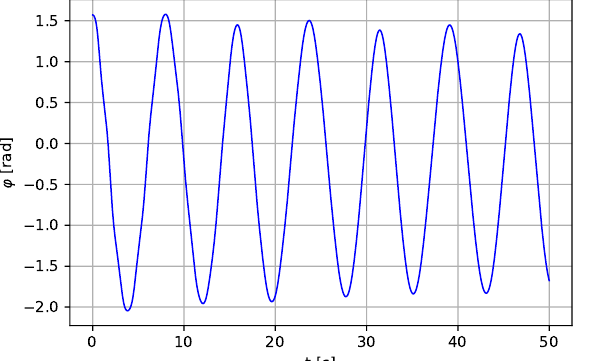
s m − 1 , ω = 0.5 rad s − 1 . · · ·